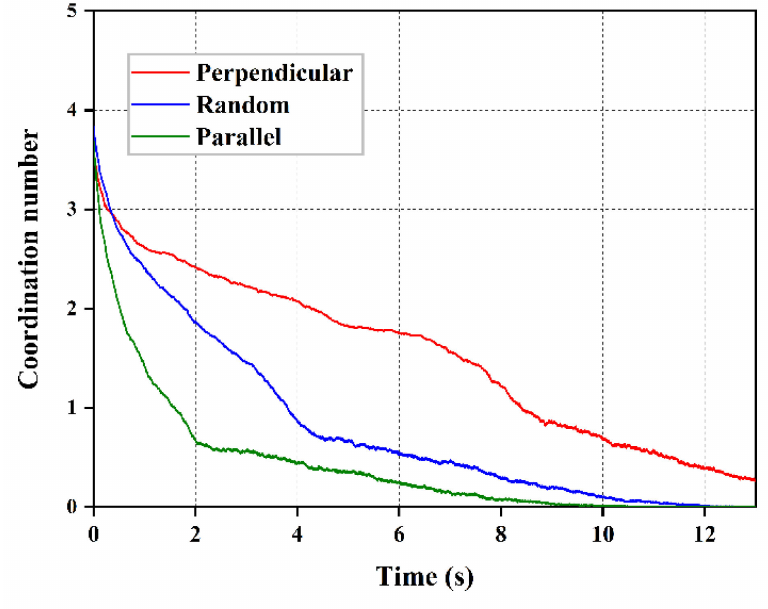
Figure 15. Evolution of coordination number between the fiber-sand